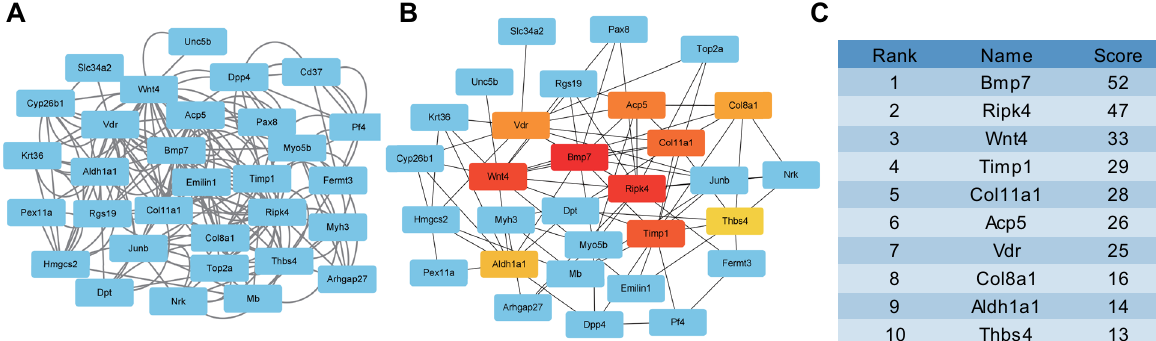
Fig. 4 The content of pyroptosis‑related proteins in NP tissues of the STZ‑induced T1DM rats measured by ELISA. n as the mean standard deviation. Data between two groups were compared by unpaired t ‑test ±